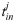
The output spike scopes.The output spike scopes generated by the input spike tinj to each layer.